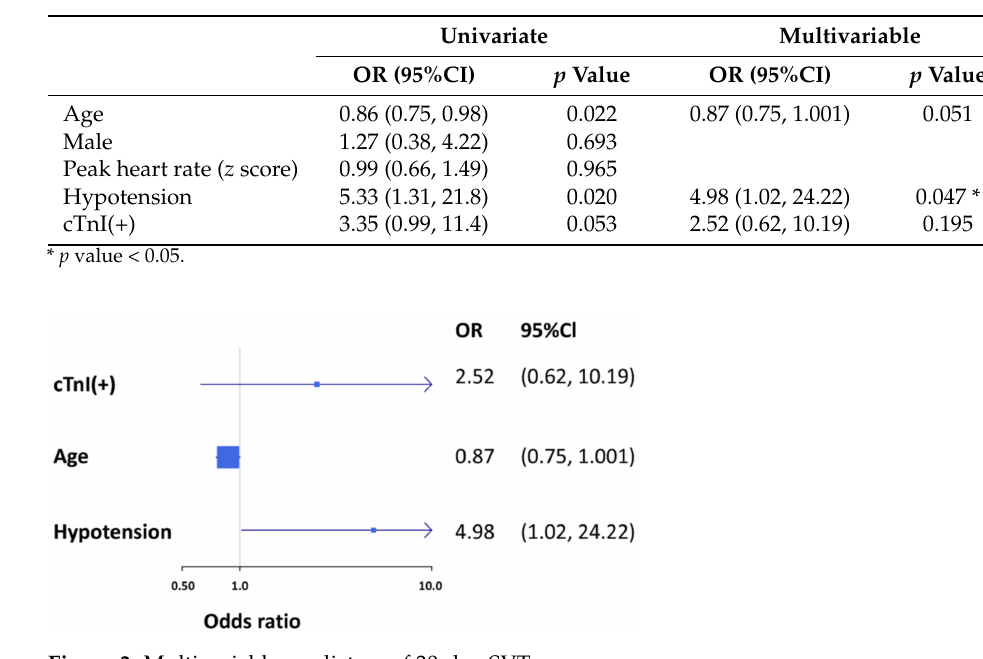
Figure 3. Multivariable predictors of 30-day SVT